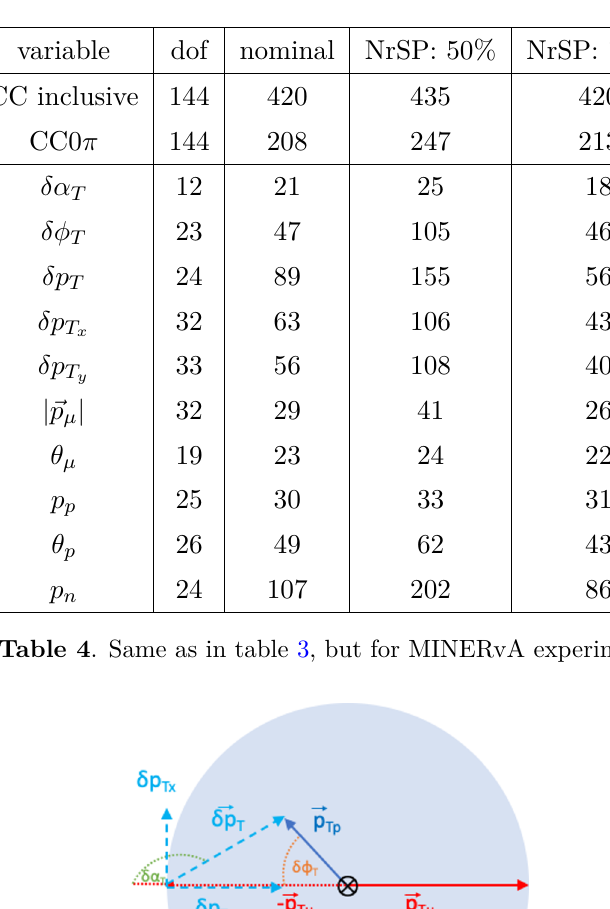
Figure 7 . Angular ( δα T , δφ t ) and transverse momentum variables ( ~δp T , δp T system, where the neutrino is entering perpendicular to the